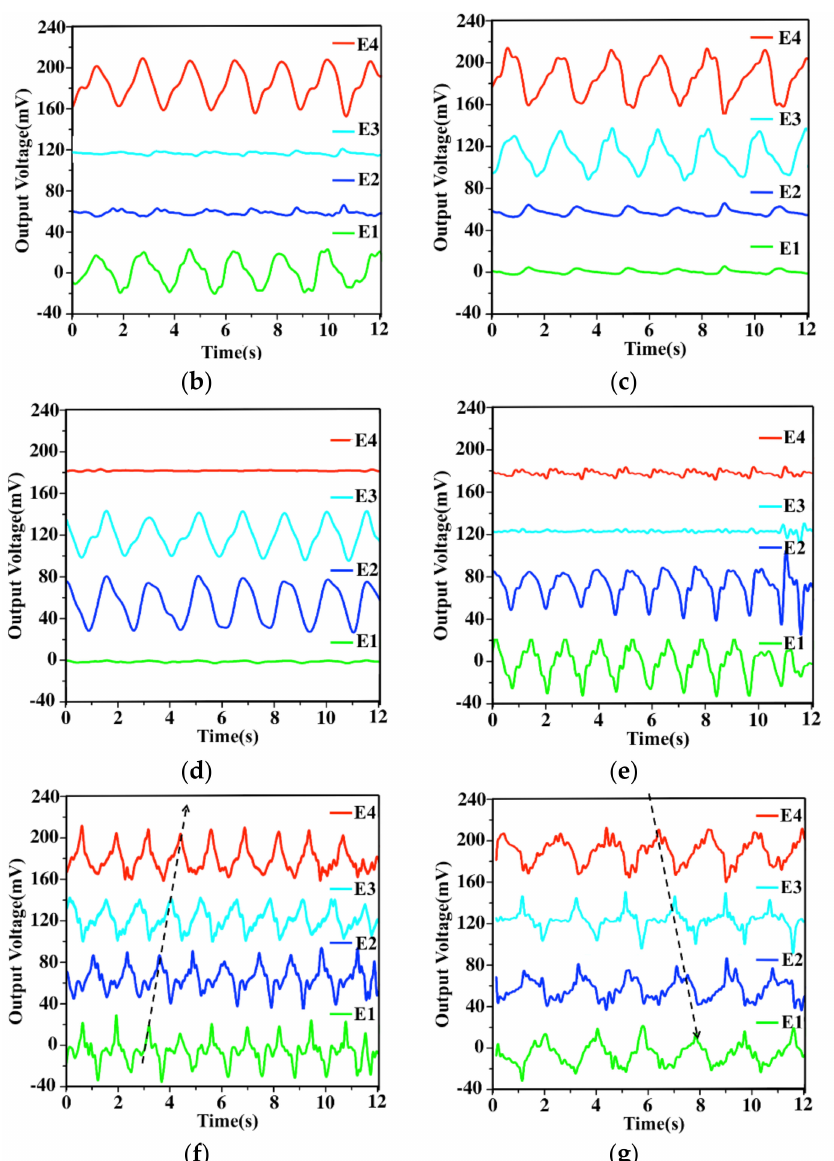
Figure 6. ( a ) The structure of module A (M-A) and the distribution of electrodes (E1–E4). ( b – e ) Output voltage waveform of M-A by repetitive motions in 0 ◦ , 90 ◦ , 180 ◦ , 270 ◦ directions. ( f , g ) Detection of the rotation direction around Y